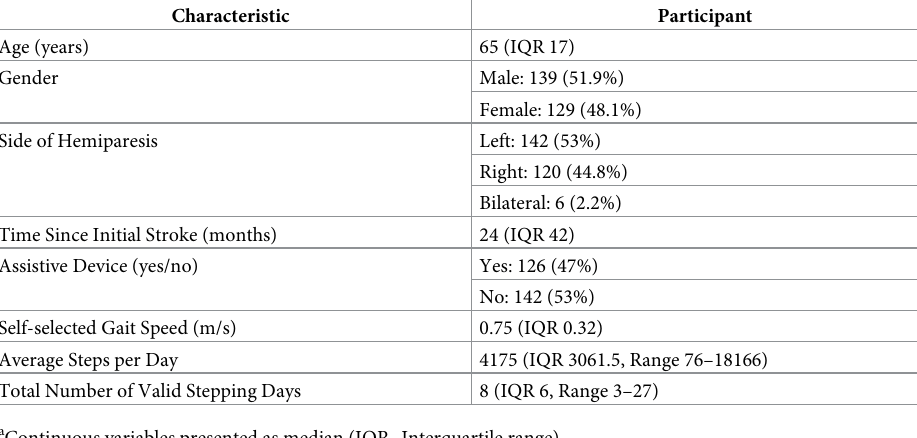
Table 3. Characteristics of study sample (n = 268) a